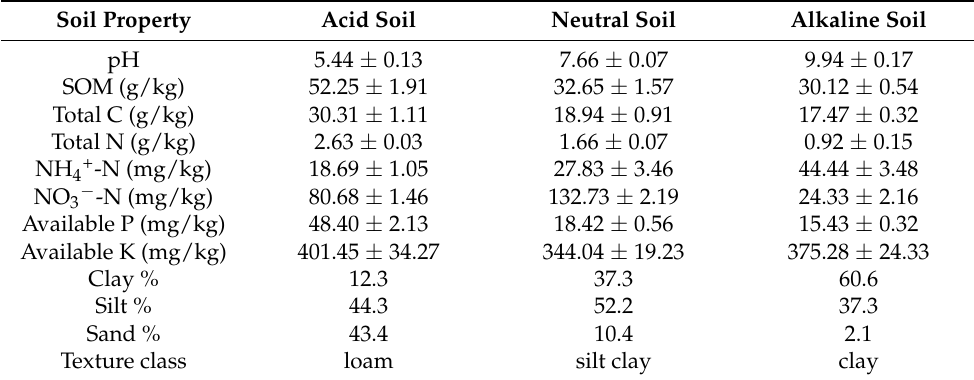
Table 1. Physicochemical properties of three different